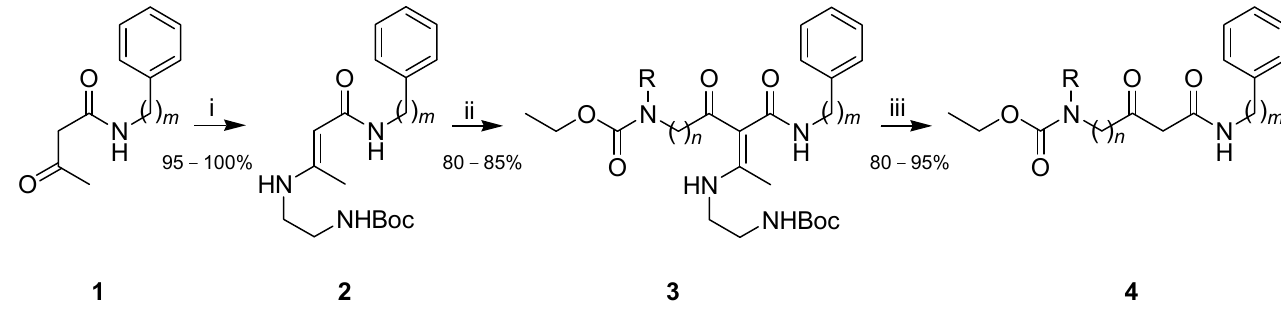
Scheme 2. Reagents and conditions: (i) BocNHCH 2 CH 2 NH 2 , CH 2 Cl 2 , Na 2 SO 4 , 24 h r.t.; (ii) N -Ethoxycarbonyl amino acid, NMM, EtOCOCl, CH 2 Cl 2 , 0 °C, 5 min; Then 2 and DMAP (0.2 equiv.) in CH 2 Cl 2 , 0 °C to r.t., 1 h.; (iii) TFA, 5 min, r.t., then aq. CH 3 COONa, 2 h, r.t. Table 1. Yields of keto amides 4 , prepared according to Scheme 2.